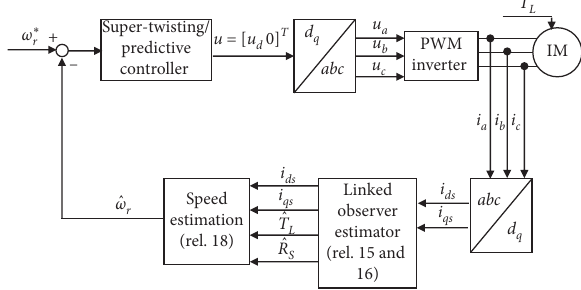
Figure 1: The estimation and control scheme proposed for the induction